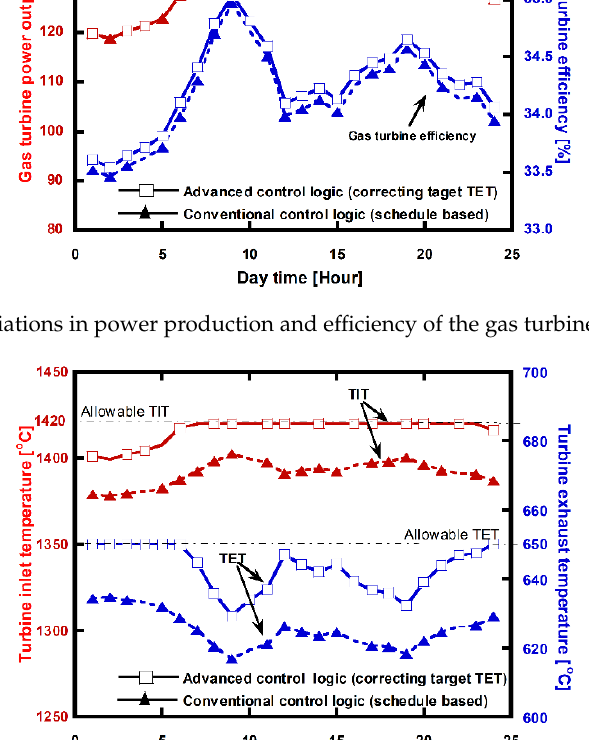
Figure 16. Simulated variations in TET and TIT of the gas turbine during a day.